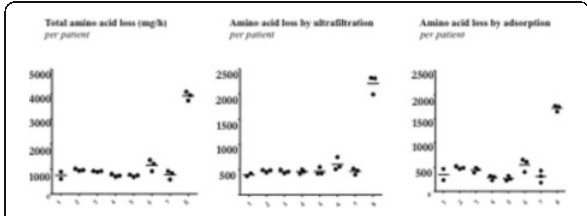
Fig. 134 (abstract A333). amino acid losses per patient (mg/h)]